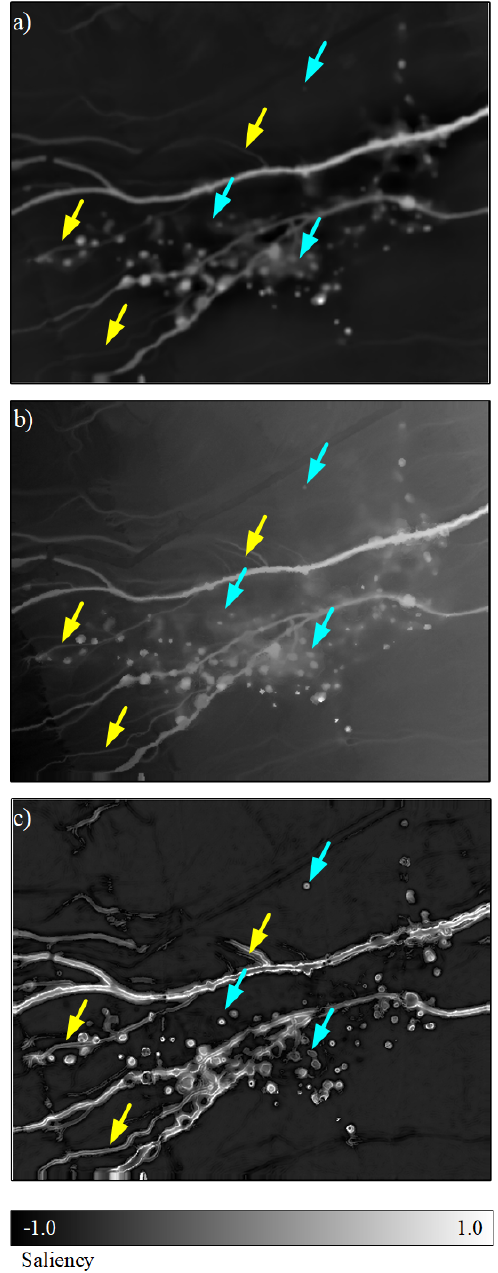
Figure 5. Saliency estimations of the alluvial fan: a) Global method (Achanta et al., 2008) with σ = 1 at four levels of 16 blurring; b) Local method (Achanta et al., 2009) with sub-region size of 5 m; c) proposed directional saliency, with σ = 0 . 2 m (based on empiric tests) and K = 8 m. The arrows mark examples to shallow gullies (yellow) or sinkholes (turquoise) that are emphasized by our